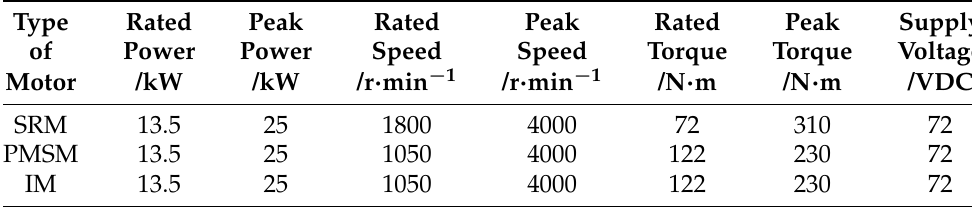
Table 2. Three walking motor